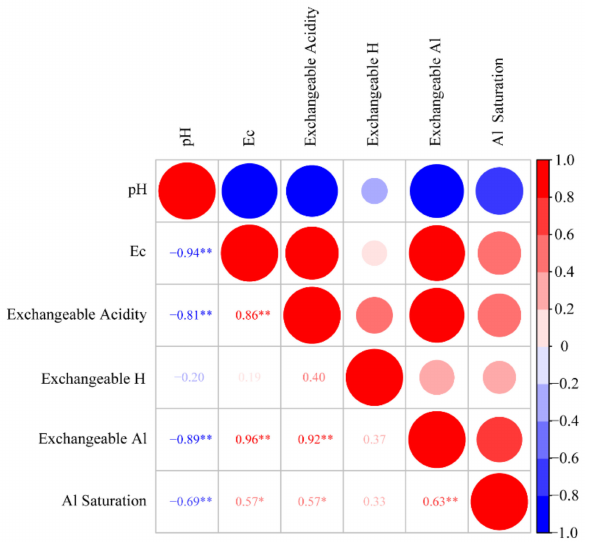
Figure 2. Correlation analysis among pH, Ec and soil exchangeable acid. The darker the color of the marker, the stronger the correlation. ** means p < 0.01, * means p <